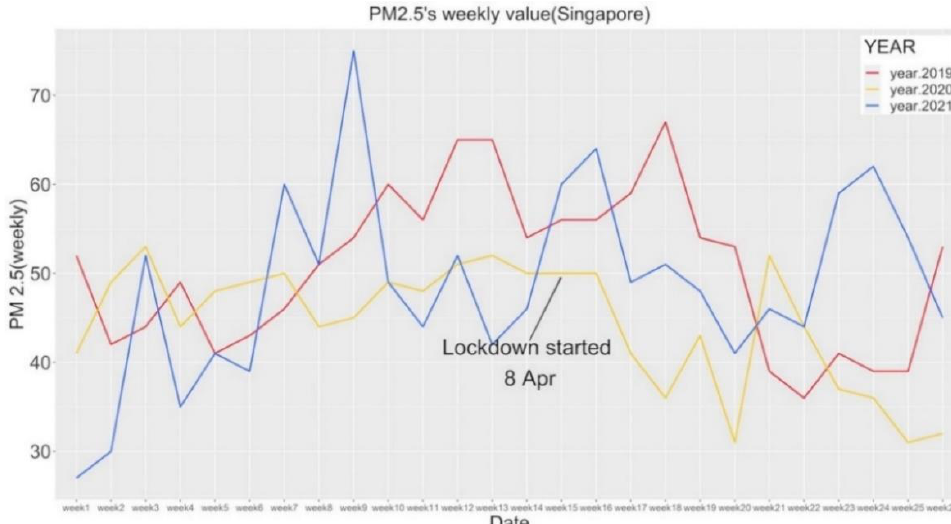
Figure 5. Weekly PM2.5 value